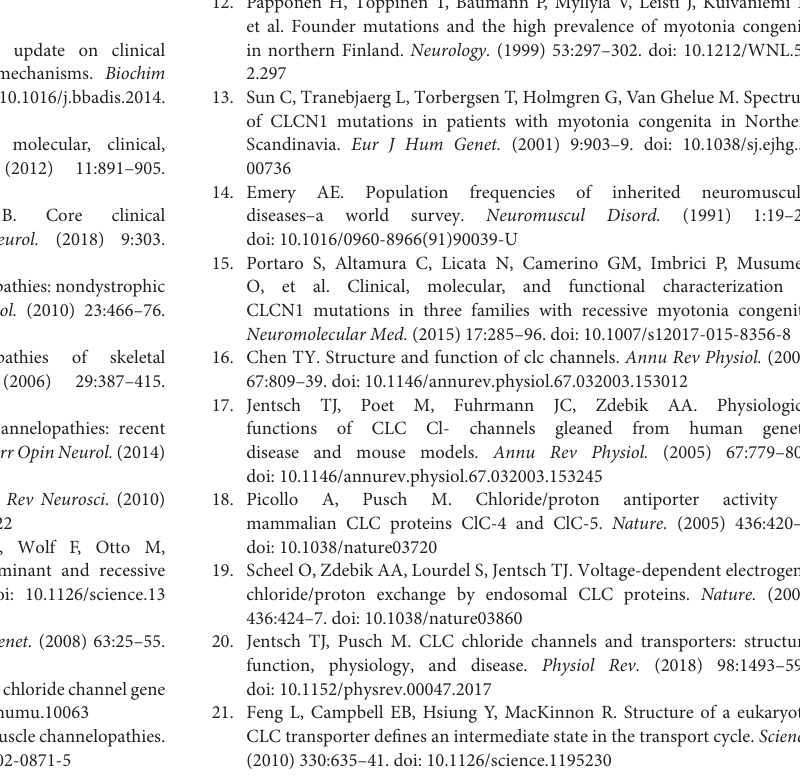
table and figures. C-JJ, T-YC, and C-YT: writing and revision of